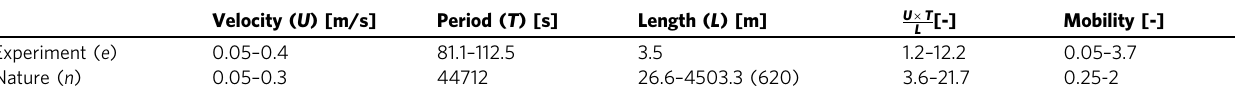
Table 1 Relevant hydrodynamic parameters in nature in comparison with hydrodynamic parameters in the